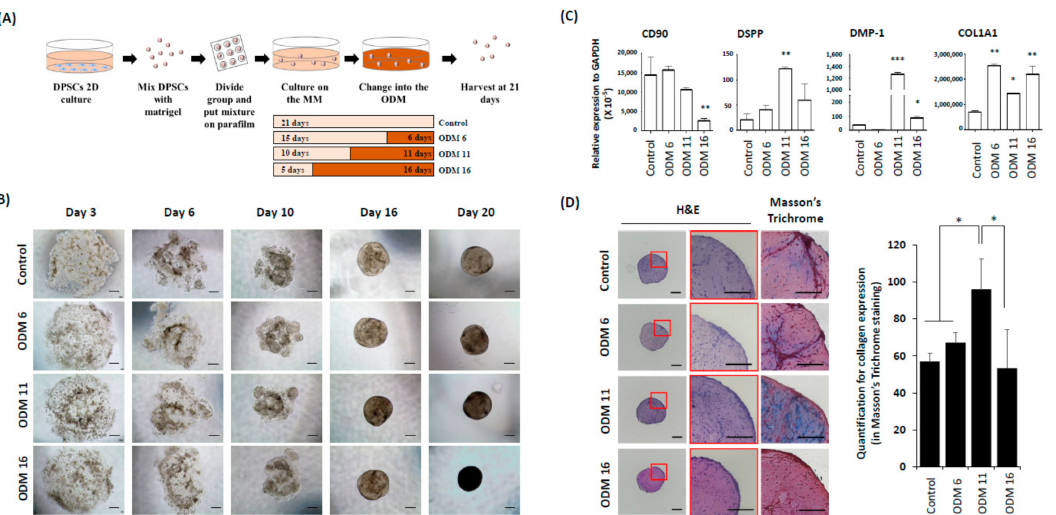
Figure 1. Development of dentin-pulp-like organoid. ( A ) After hDPSCs culture in 2D condition using conventional growth medium, hDPSCs were mixed with Matrigel and adhered onto a